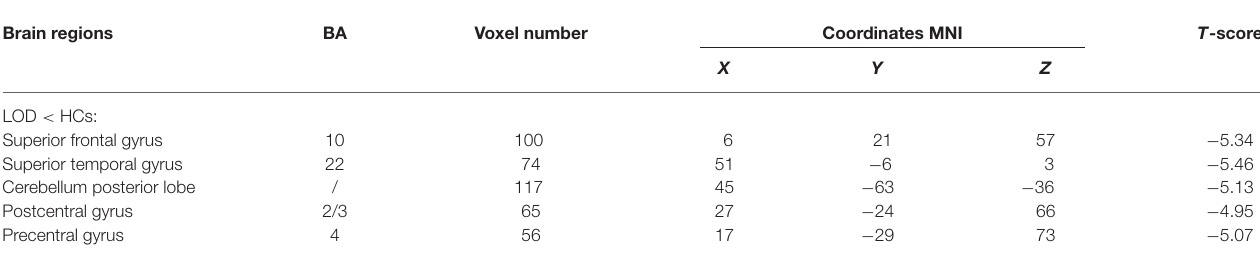
TABLE 2 | The decreased regional VMHC in LOD group relative to